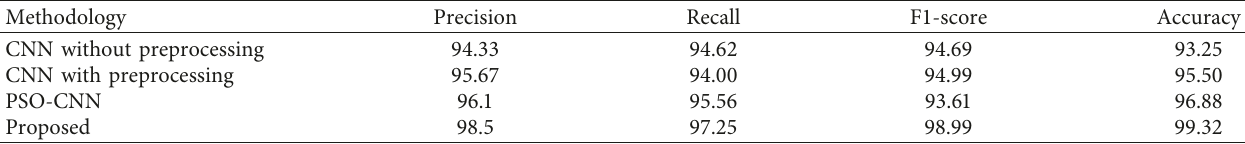
Table 5: Comparative analysis of proposed method after data augmentation process.